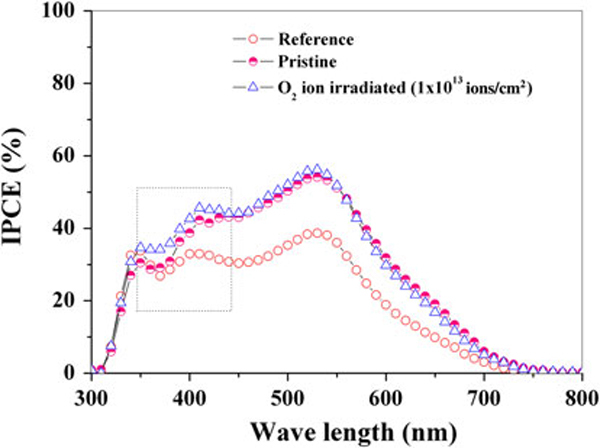
IPCE spectra of DSSCs using different TiO2blocking layers.